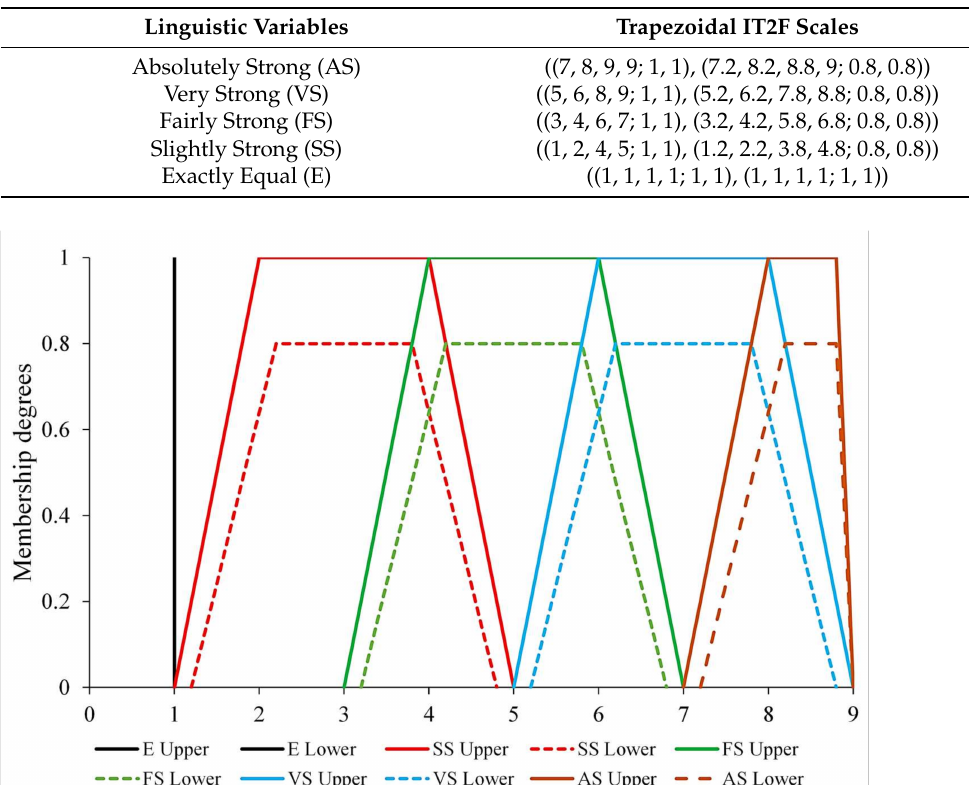
Table 1. Definition of the linguistic variables and the equivalent IT2F scales.